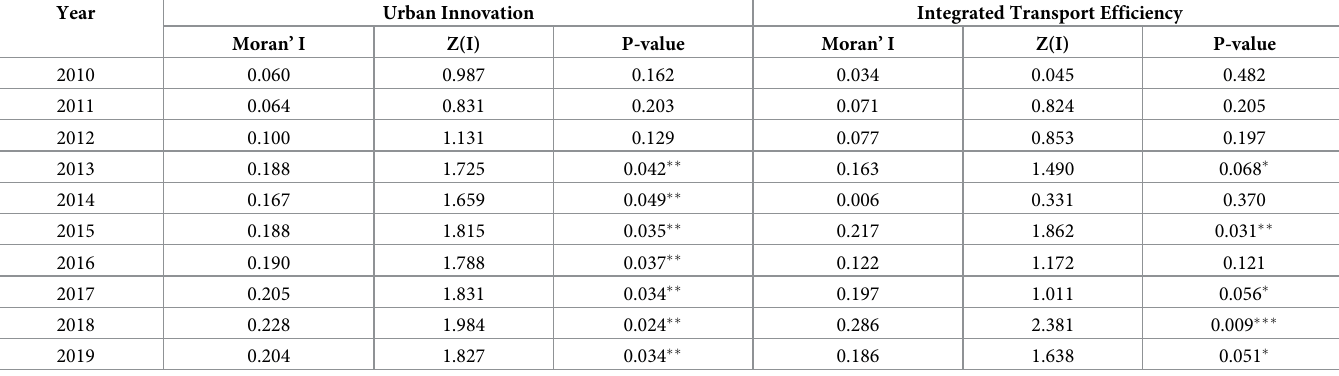
Table 3. Global spatial autocorrelation test results of urban innovation and integrated transport efficiency under the economic space distance weight matrix in the Yangtze River Delta.